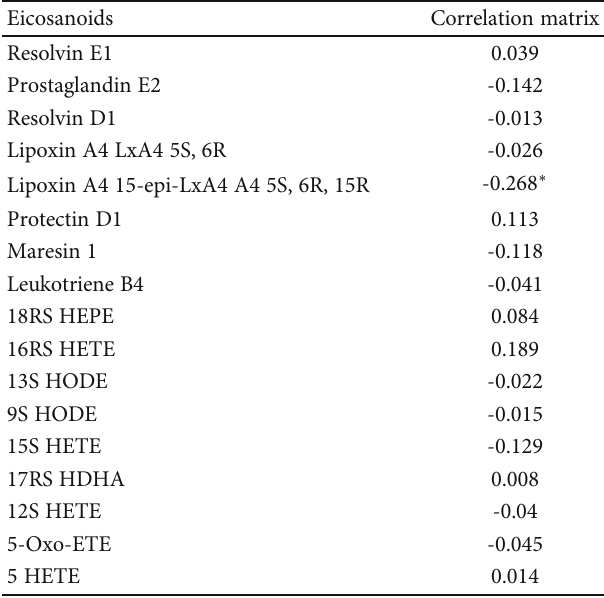
Figure 3: The relationship between BDNF and C22:1n9 13 erucic acid ( r Table 2: Correlation matrix between BDNF and eicosanoid levels. Eicosanoids Correlation